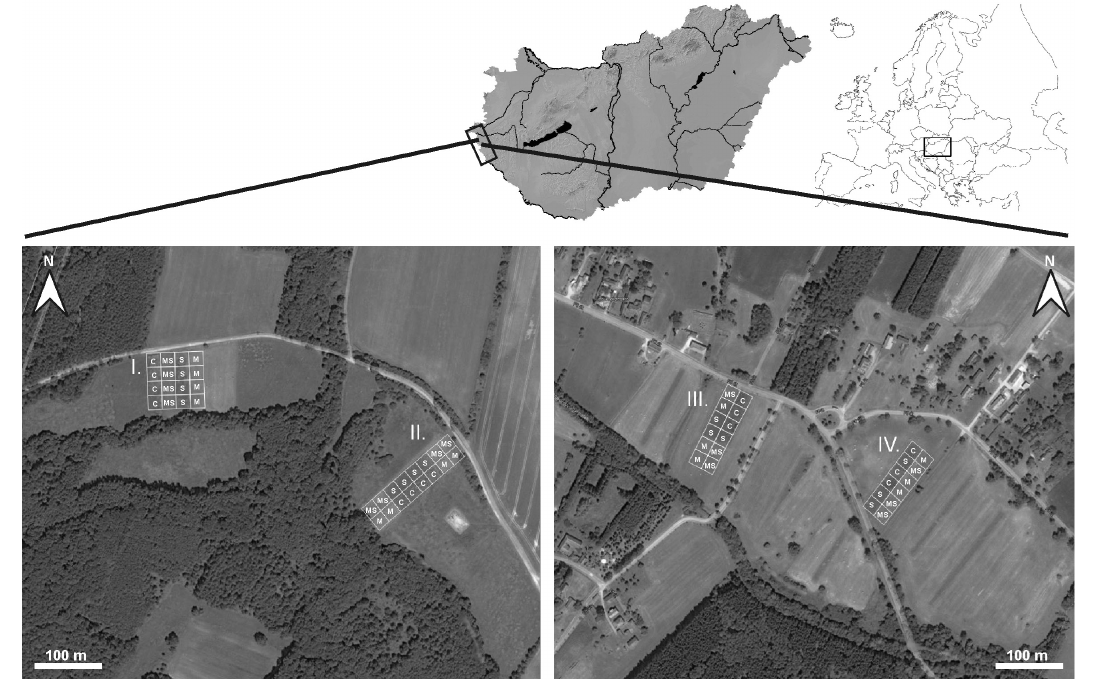
Figure 1. Location of the four study sites in Ő rség National Park and the quadrats of different mowing regimes (quadrats are 20 × 20 metres; M: mowing once a year in May; MS: mowing twice a year in May and September; S: mowing once a year in September; C: